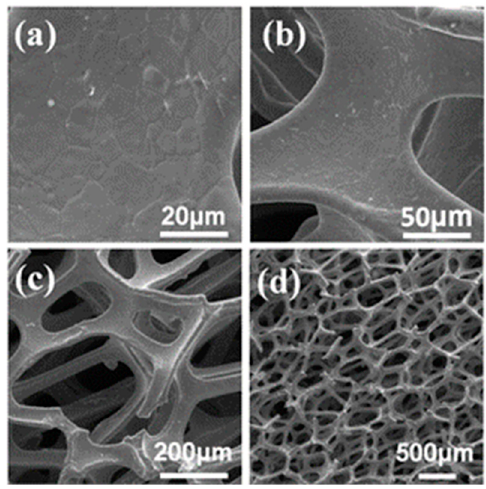
Figure 2. SEM images showing phase structure and morphology of bare Ni foam at different magnification levels: ( a ) 20, ( b ) 50, ( c ) 200, and ( d ) 500 µm.